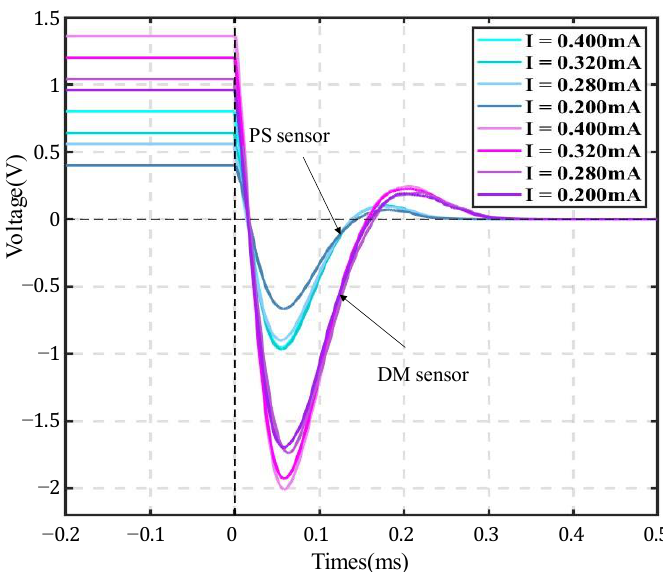
Figure 20. Graph of free damping motion under different excitation of currents.